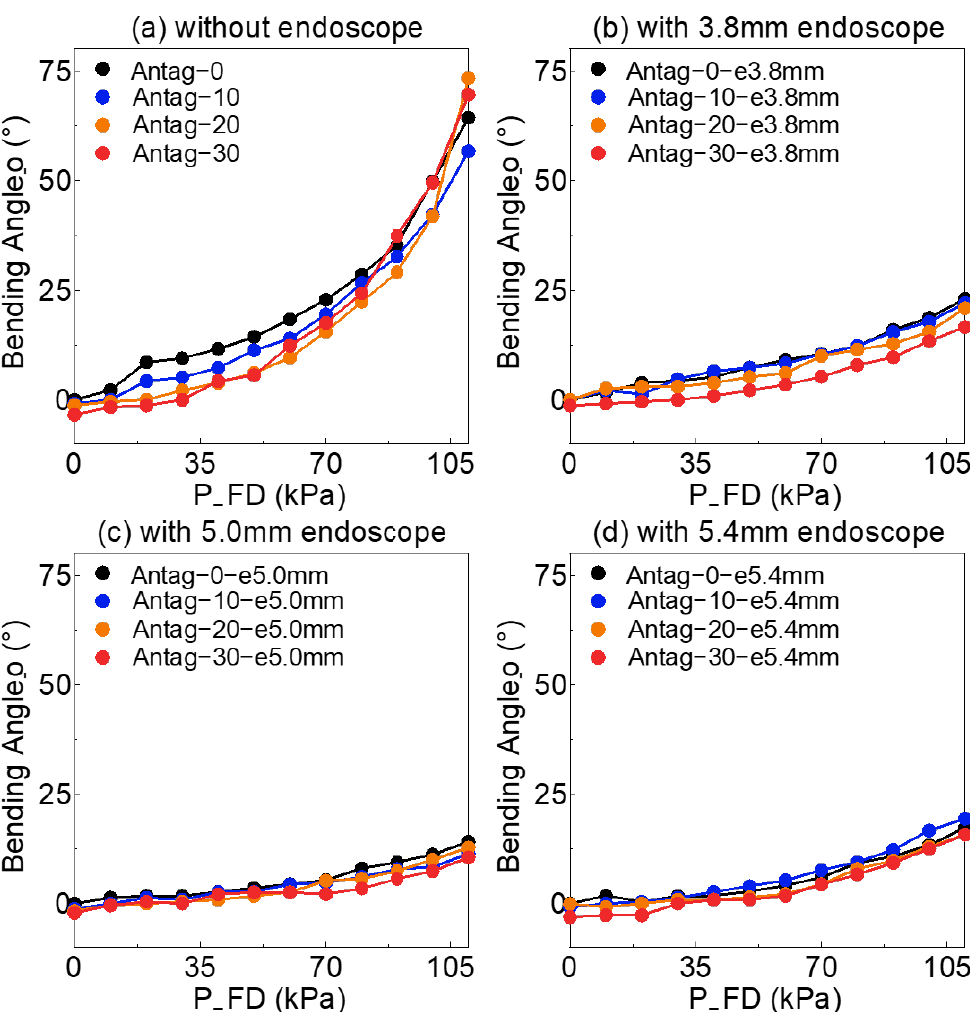
Figure 4. The variation of soft actuator’s bending angle before applying external load under different sets of FU and FD air pressure ( a ) without endoscope: without inserting endoscope into soft actuator for experiment, ( b ) with 3.8 mm endoscope: inserting 3.8 mm endoscope into soft actuator for experiment, ( c ) with 5.0 mm endoscope: inserting 5.0 mm endoscope into soft actuator for experiment, ( d ) with 5.4 mm endoscope: inserting 5.4 mm endoscope into soft actuator for experiment.